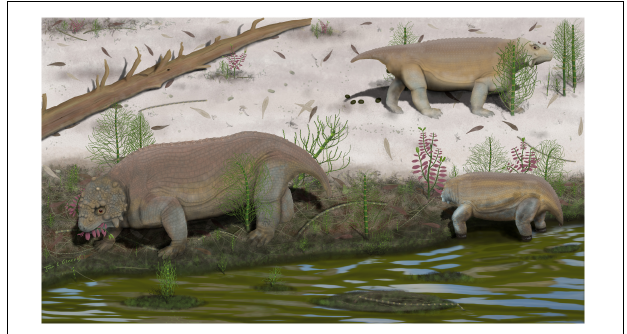
FIGURE 15 | Life reconstruction of Provelosaurus americanus in its habitat. Plant genera represented are Glossopteris , Paracalamitina, and Schizoneura . Art by